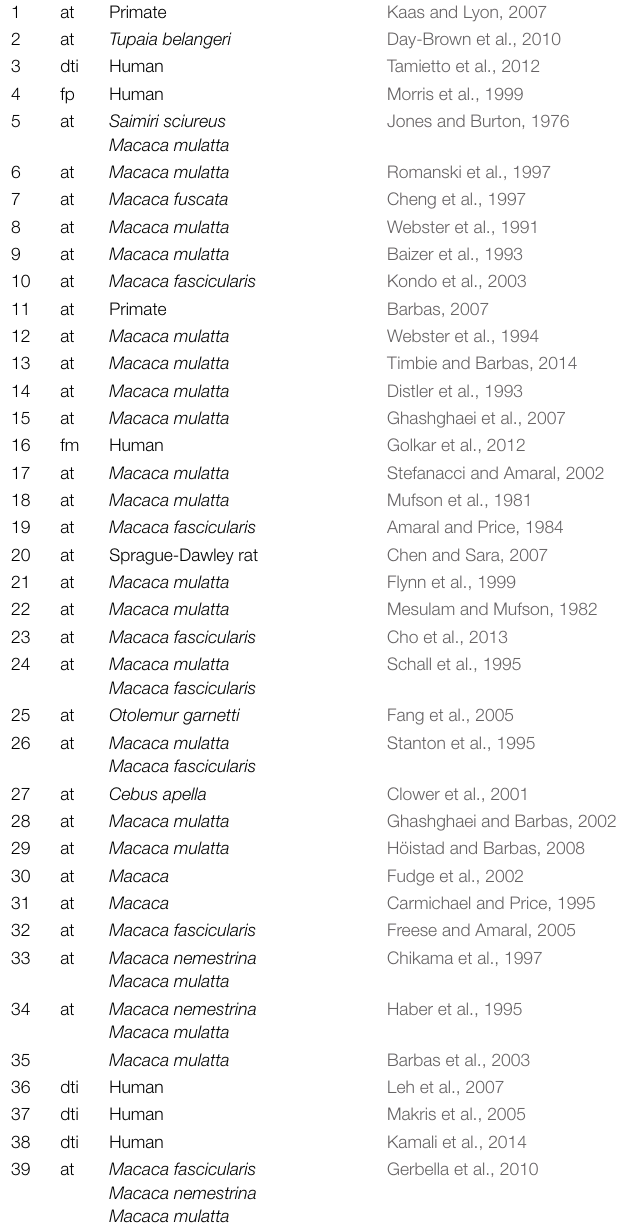
TABLE 2 | Numbered references for projections in Figure